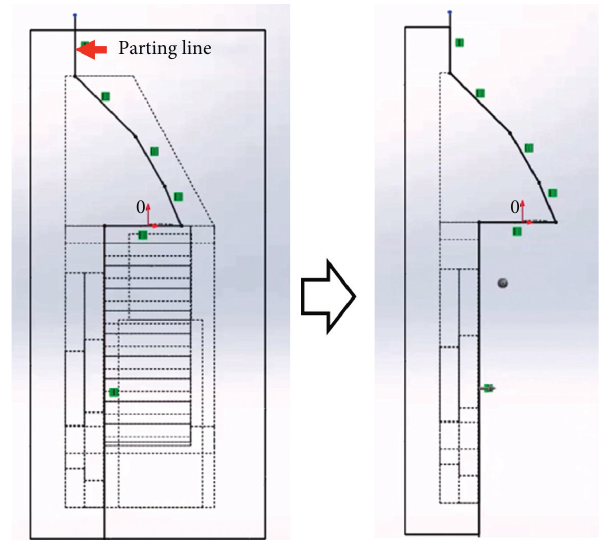
Figure 15: Schematic diagram of the parting line of the mold